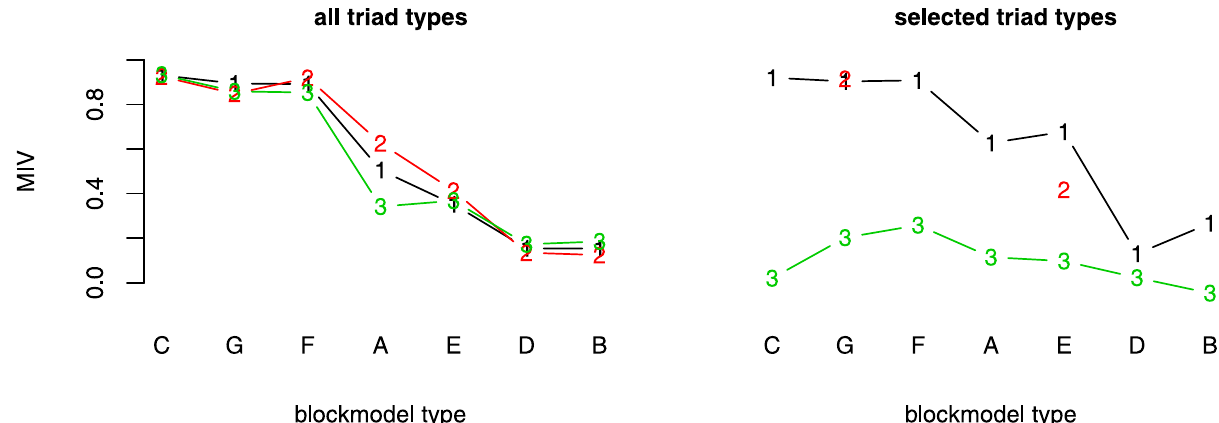
Fig 6. The MIV for each blockmodel type (generated by the MCMC algorithm with fixed density) and selected set of triad types. (A) cohesive; (B) symmetric core-periphery; (C) asymmetric core-periphery; (D) hierarchical without complete blocks on the diagonal (E) hierarchical with complete blocks on the diagonal; (F) transitivity without complete blocks on the diagonal; (G) transitivity with complete blocks on the diagonal, (1) allowed and forbidden triad types, (2) allowed triad types, (3) forbidden triad types. Note: only the networks of transitivity with complete blocks on the diagonal blockmodel type and hierarchical with complete blocks on the diagonal blockmodel type were generated by considering the selected allowed triad types.